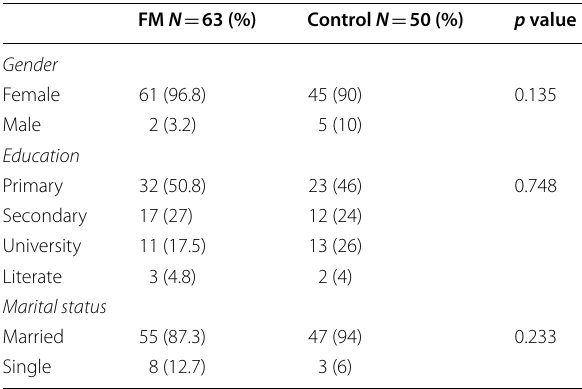
Table 1 Demographic data of Fibromyalgia syndrome patients and control group and comparison between groups